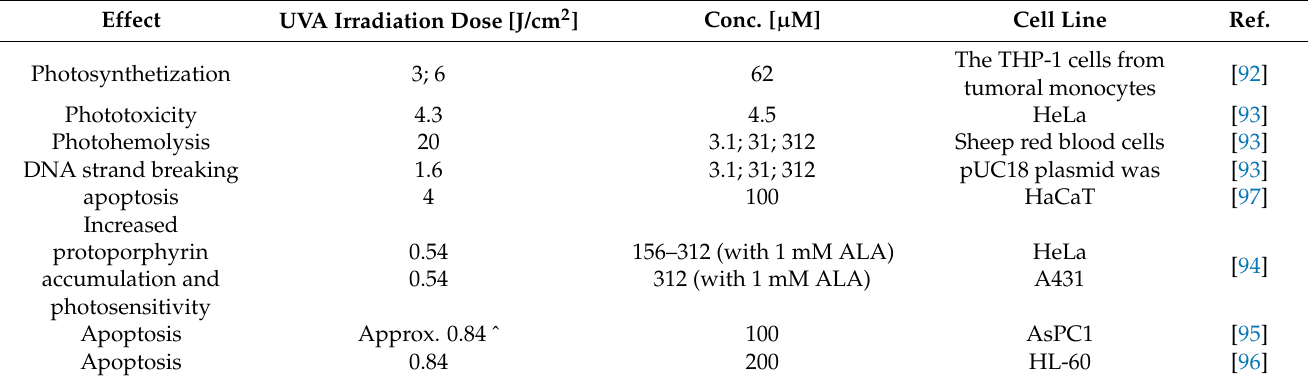
Table 4. Phototoxic effects of enoxacin depending on the UVA irradiation dose in in vitro